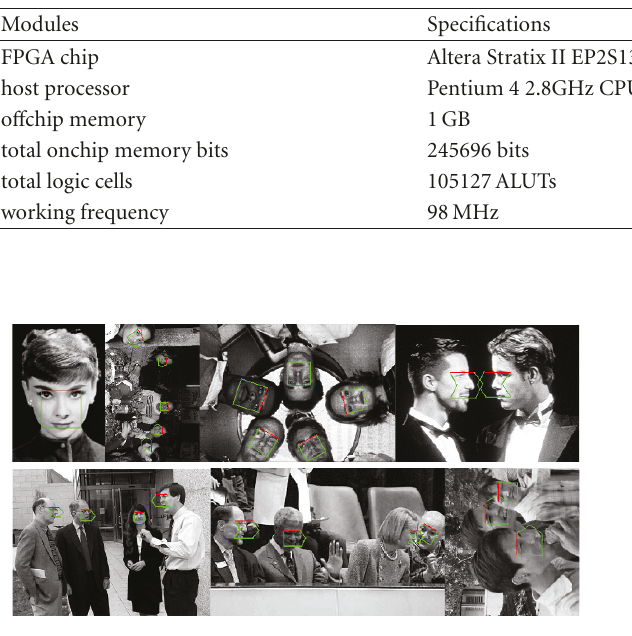
Figure 13: Some detection results of the proposed hardware RIMVFD system.